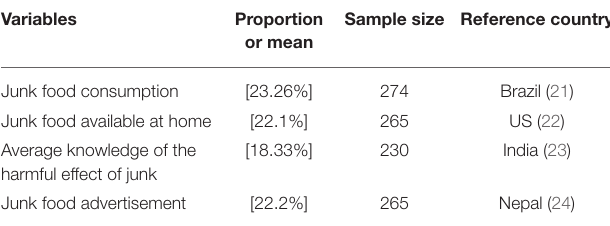
TABLE 1 | Sample size calculation table.